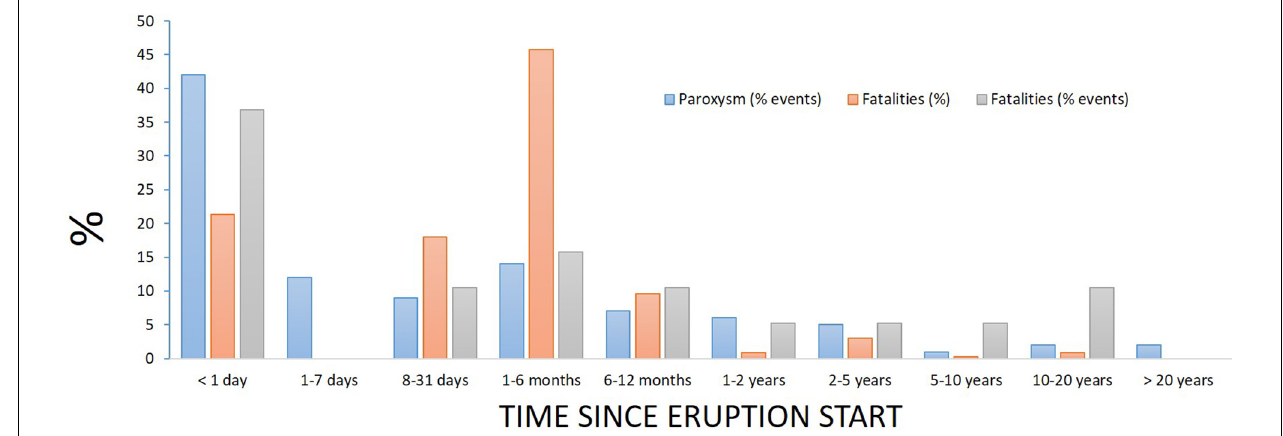
FIGURE 1 | Distribution of the timing of fatalities relative to the start of eruptions. ‘Paroxsyms’ are the occurrence of more violent volcanic activity during a longer sequence of eruption as defined and reported in Siebert et al. (2015). Distribution from 252 events of known duration and intensity in historical record. Fatality timing uses data in Table 1 , expressed as % of events and % of overall number of